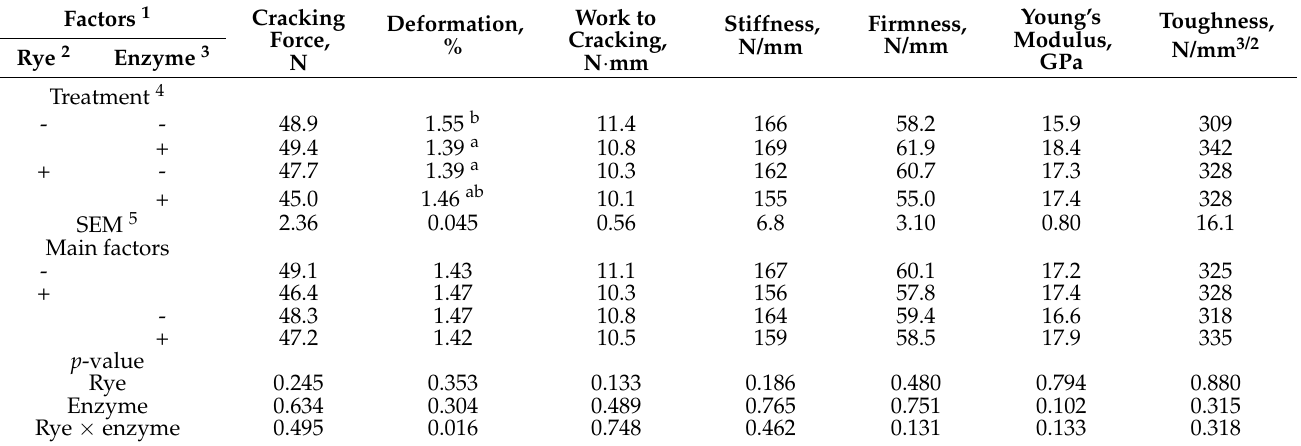
Table 4. Effect of 25% dietary rye inclusion and xylanase supplementation (200 mg/kg of feed) on eggshell mechanical properties at the end of the laying cycle–mechanical testing in the polar plane.